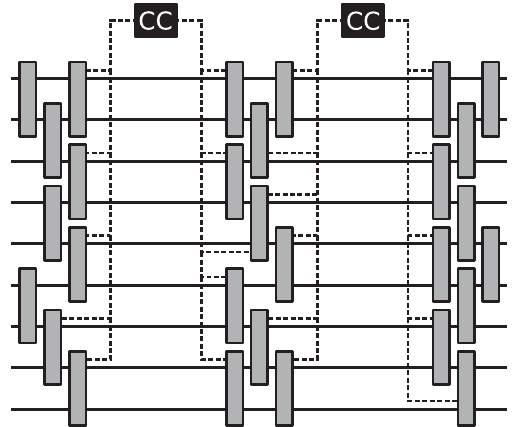
FIG. 1. A quantum-local process involves a finite number of local operation rounds, each with a classical output that is globally processed to provide an input for the next